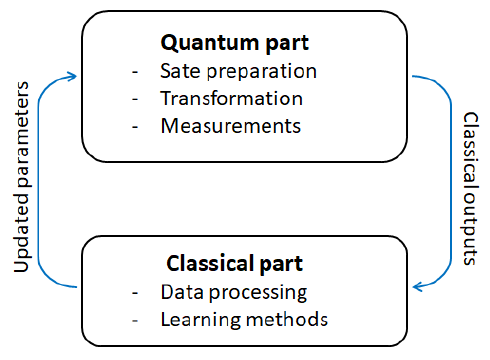
Figure 1. Illustration of a hybrid quantum–classical